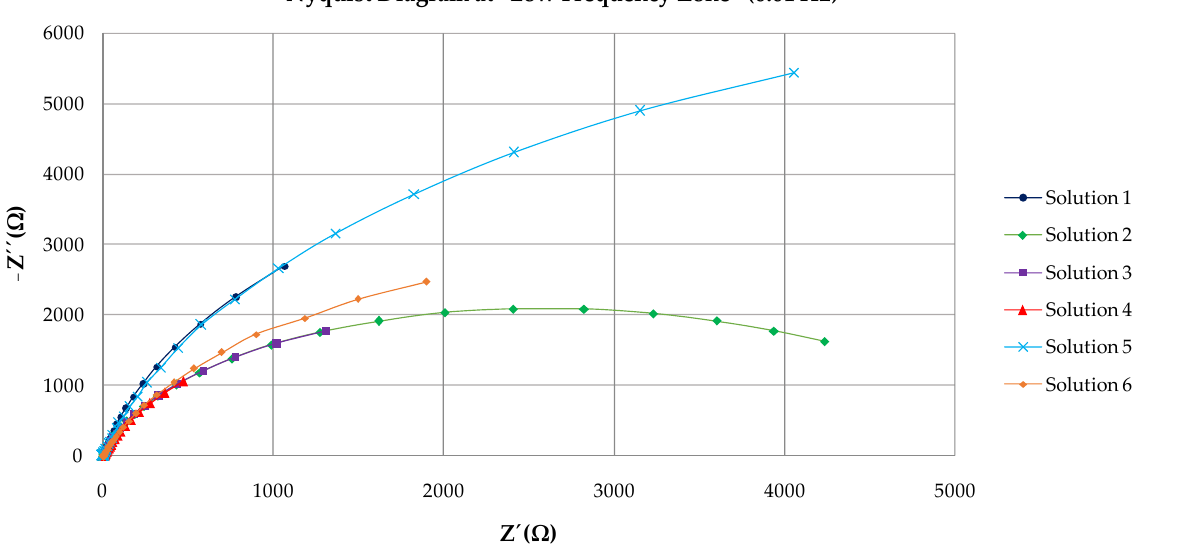
Figure 6. Nyquist diagram in “Low-Frequency Zone” (0.01 Hz).